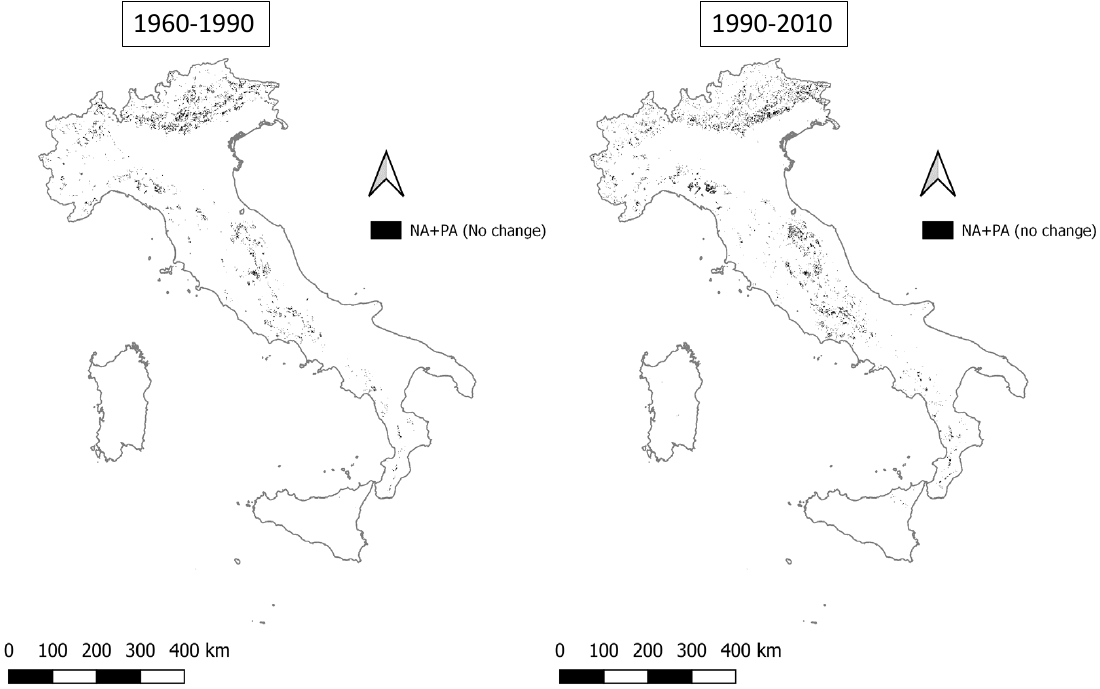
suggesting that these areas can be considered as buffer zones that strongly maintain the vegetation, and land use. These areas amount to 1.96% in the period 1960–1990 and grow to 2.45% in the period 1990–2010 (Table 4).